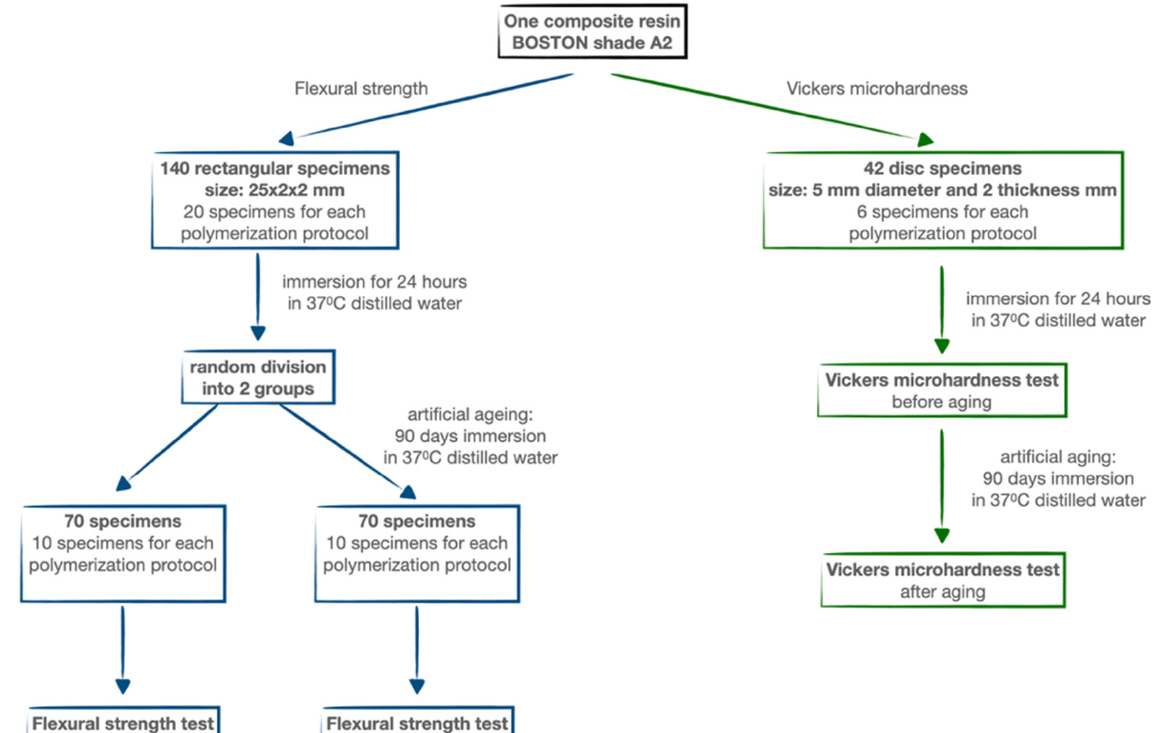
Figure 2. Flow chart of the research process.